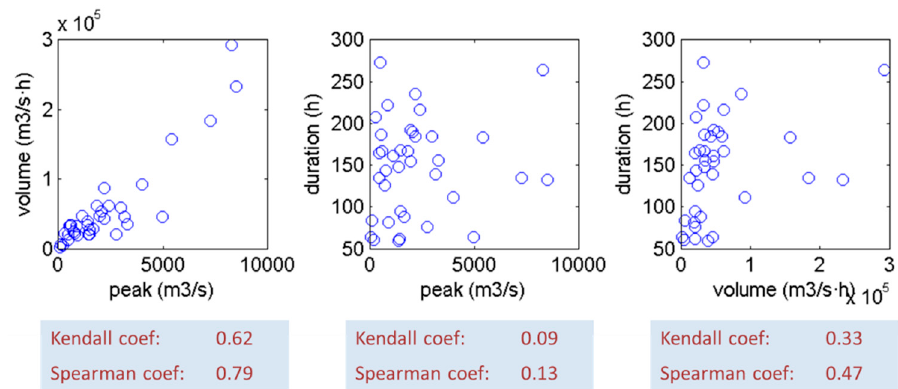
Figure 2. Bivariate scatter figures and coefficients of historic flood peak, volume, and duration.